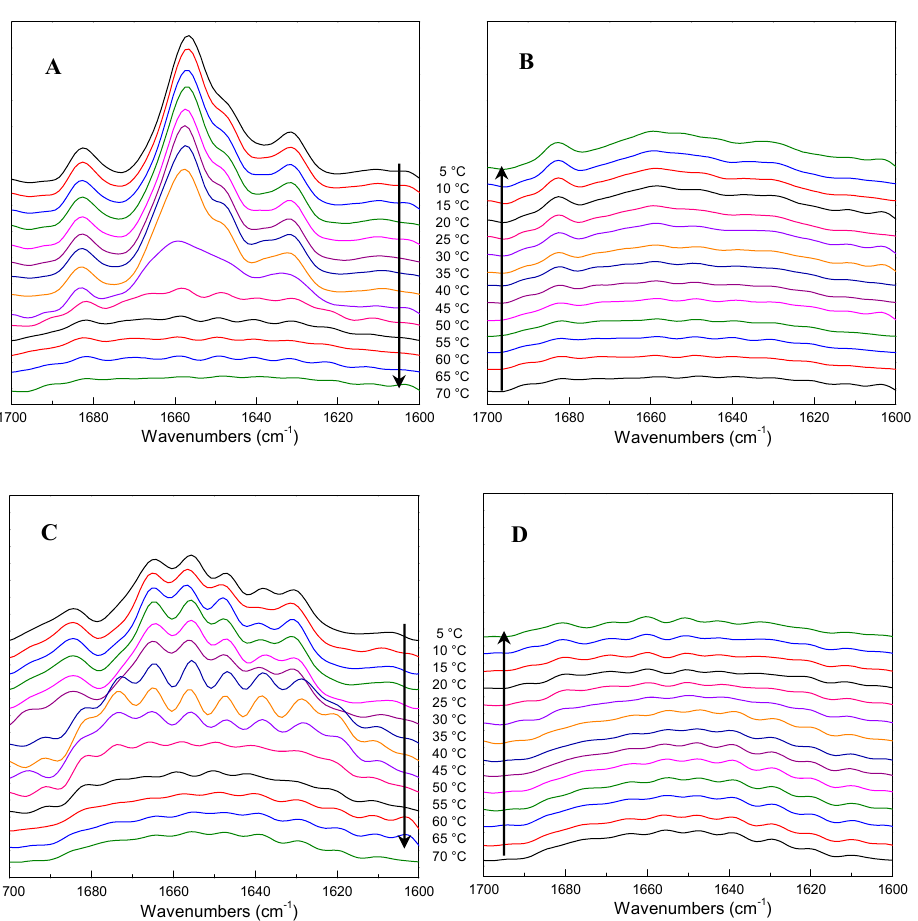
Figure 4. Fourier self-deconvolved infrared spectra in the amide I region of ICFs ( A : heating; B : cooling) and PSCs ( C : heating; D : cooling) (5% w / v in D 2 O).